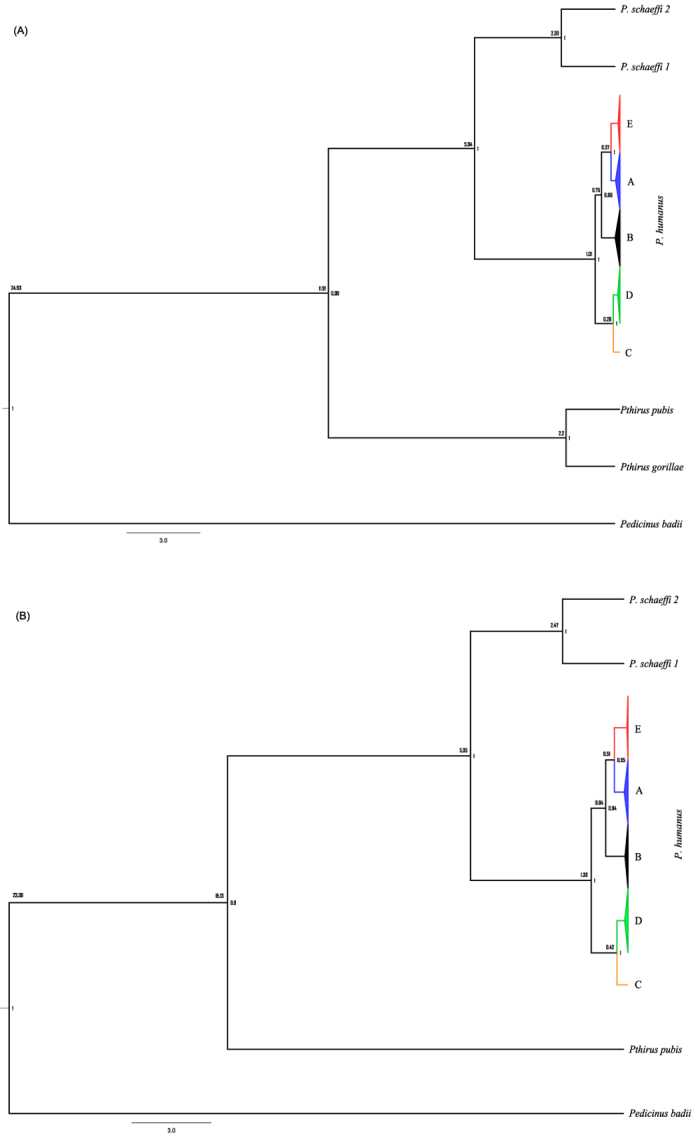
Phylogenetic and divergence time analysis of COI (A) and cytb (B) sequences for head lice clades, including lice from other primates, using Bayesian inference and BEAST.Posterior probabilities are indicated inside while divergence time (million years) outside the nodes. The node for each clade with multiple sequences is collapsed.